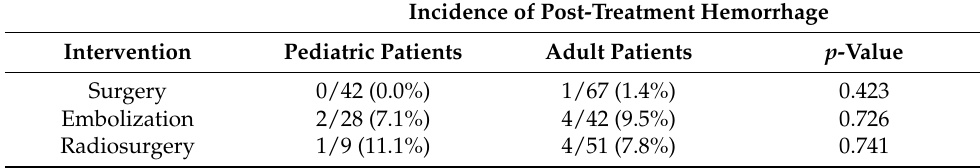
Table 3. Incidence of Post-treatment Hemorrhage by Intervention.